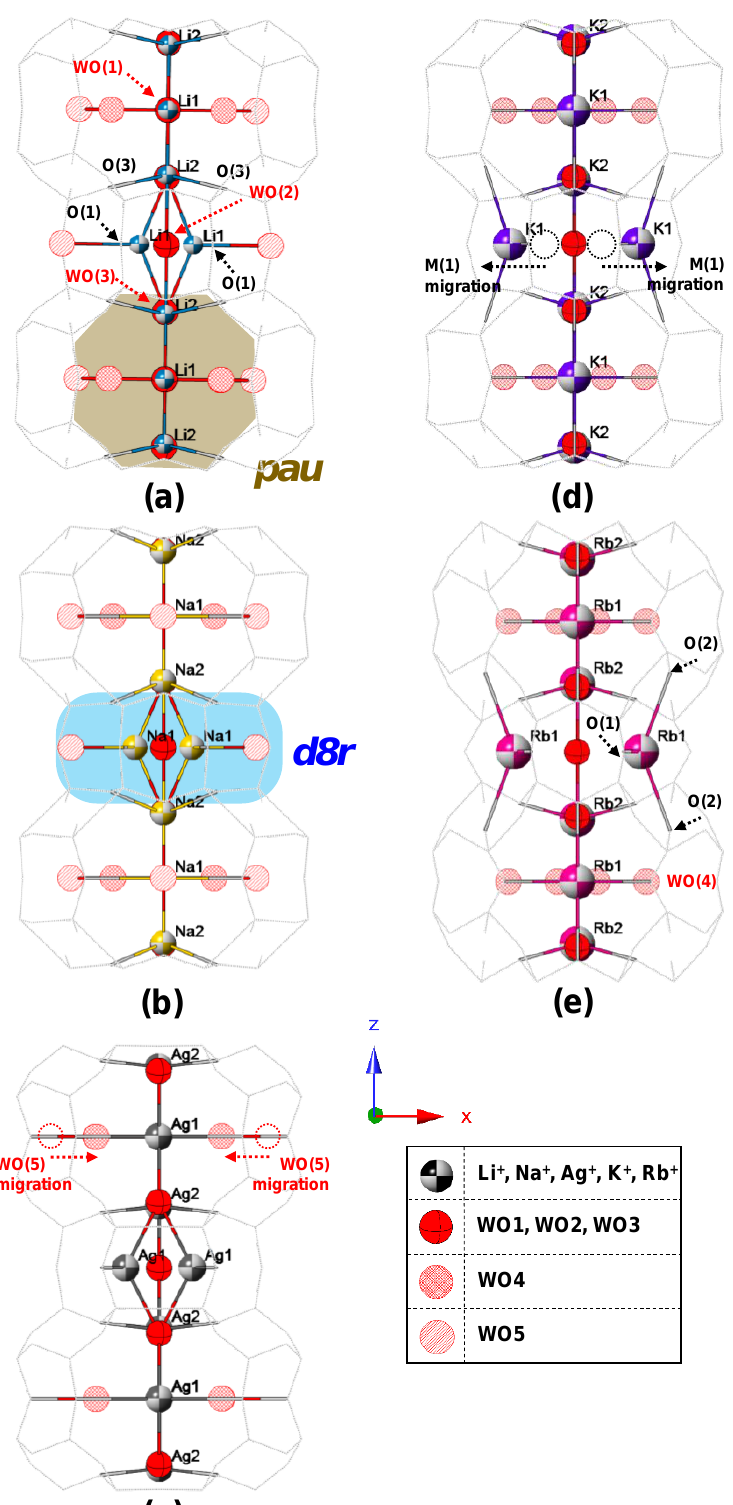
Figure 3. Polyhedral representations of ( a ) Li-MER, ( b ) Na-MER, ( c ) Ag-MER, ( d ) K-MER, and ( e ) Rb-MER along the (010) direction. The grey stick represents disordered Al/Si framework. Each colored beach ball represents an extra-framework cation. Equatorial, hatched, and striped red balls represent oxygens of WO(1)–WO(3), WO(4), and WO(5), respectively.